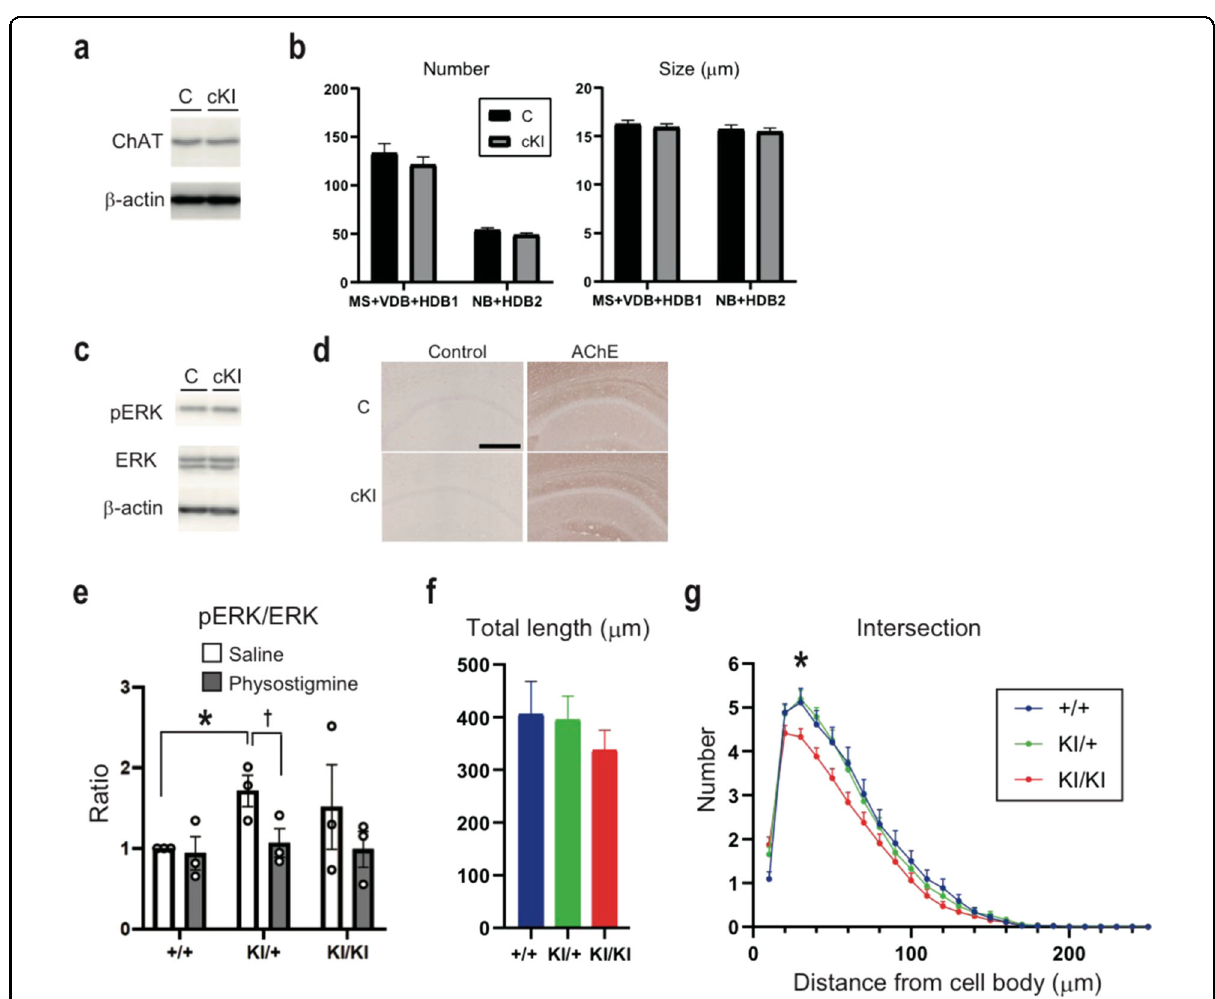
Fig. 5 Development and maintenance of the basal forebrain cholinergic neurons were similar among genotypes; but postsynaptic defects were observed in the hippocampal neurons of the Ntrk1 KI mice. a Western blots of the ChAT protein using the basal forebrain tissue homogenates. N = 3 for each genotype, representative blots were shown. b Numbers and sizes of the basal forebrain cholinergic neurons, N = 3 pairs. MS medial septum, VDB ventral limb of the diagonal band of Broca; HDB horizontal limb of the diagonal band of Broca, NB nucleus of basalis. c Western blots of the pERK and ERK proteins using the basal forebrain tissue homogenates. N = 3 pairs, representative blots were shown. d Acetylcholine esterase immunohistochemistry in the hippocampal CA1 region. Bar, 250 μ m. Acetylcholine esterase (AChE) immunohistochemistry in the hippocampal CA1 region. Anti-AChE antibodies (HPA019704, Sigma-Aldrich) were used. Bar, 250 μ m. e pERK/ERK ratios of the hippocampus by fl uorescence western blots using the tissue homogenates under saline or physostigmine administration. N = 3 pairs. * p < 0.05; † p = 0.070 ( t -test, two- tailed); Error bars, mean ± s.e.m. f Total length of the dendrites in the primary hippocampal neurons. g Number of intersections in the dendrites of the primary hippocampal neurons. f , g + / + , N = 44; KI/ + , N = 84; KI/KI, N = 85 neurons were counted. * p < 0.05 (One-way ANOVA followed by Fisher ’ s PLSD post-hoc test); Error bars, mean ±